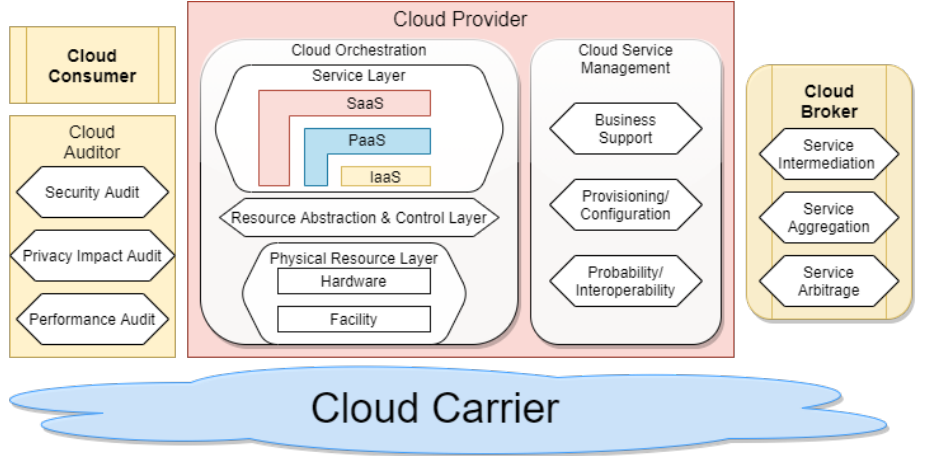
Figure 17. NIST’s updated cloud computing reference architecture